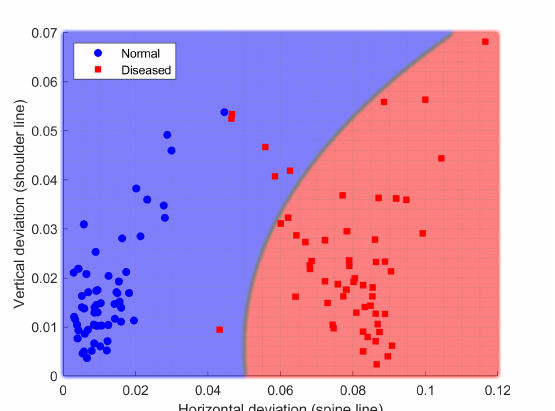
Figure 20. Separation of subjects by correctness of physical exercise performance using spine and shoulder line data.